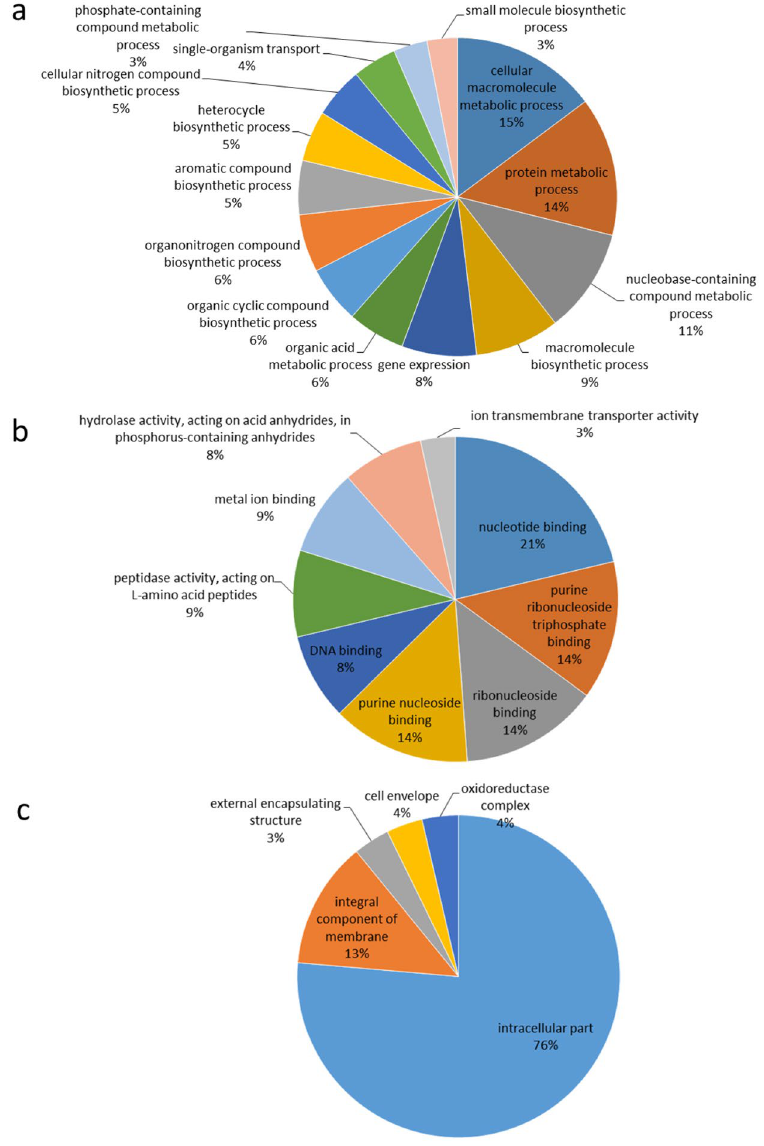
Figure 10. Gene ontology-based functional characterization of the differentially expressed proteins in M. aeruginosa under PG stress. Distribution of the differentially expressed proteins in terms of biological processes ( a ), molecular function ( b ), cellular components ( c